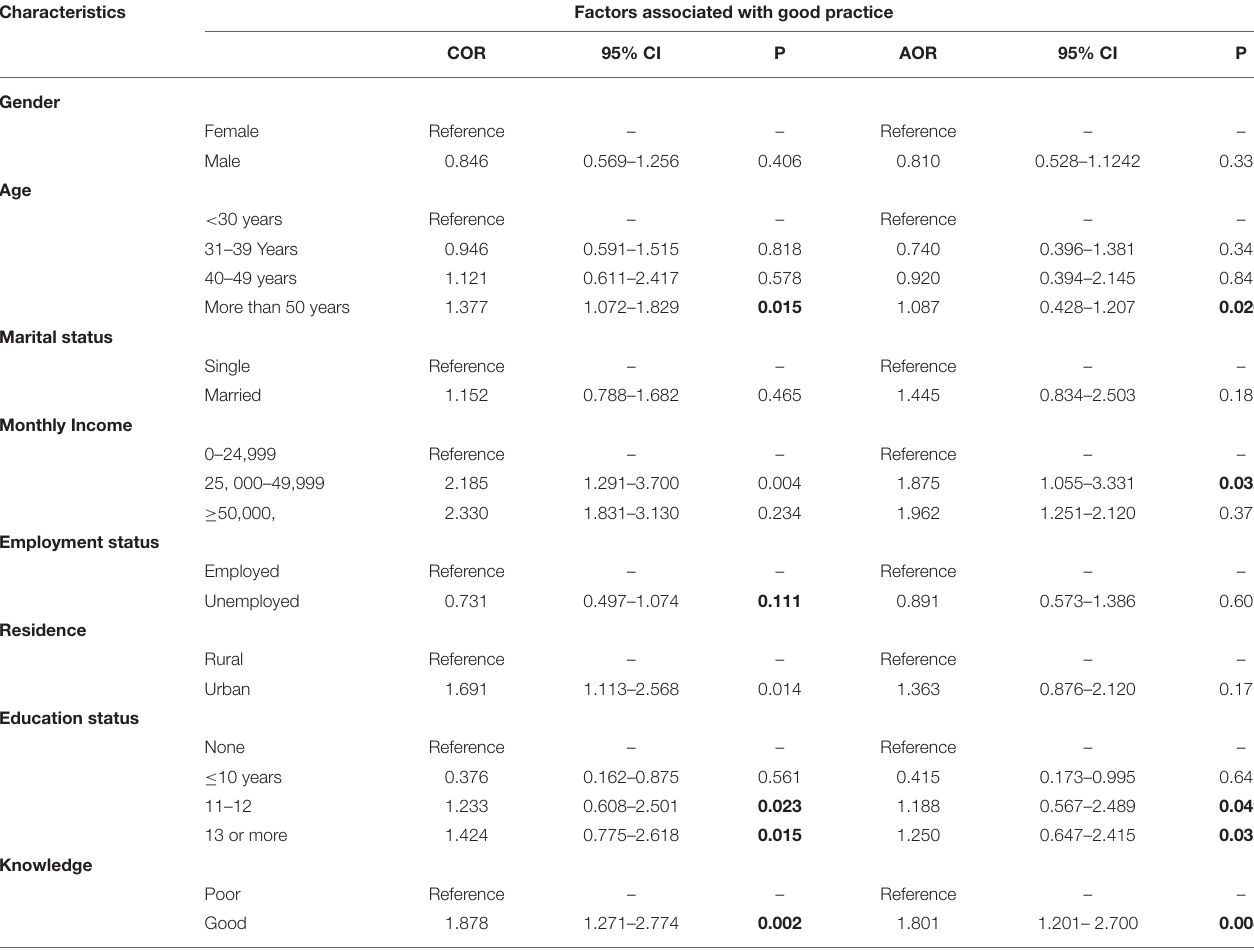
TABLE 4 | Binary logistic regression analysis for factors associated with good